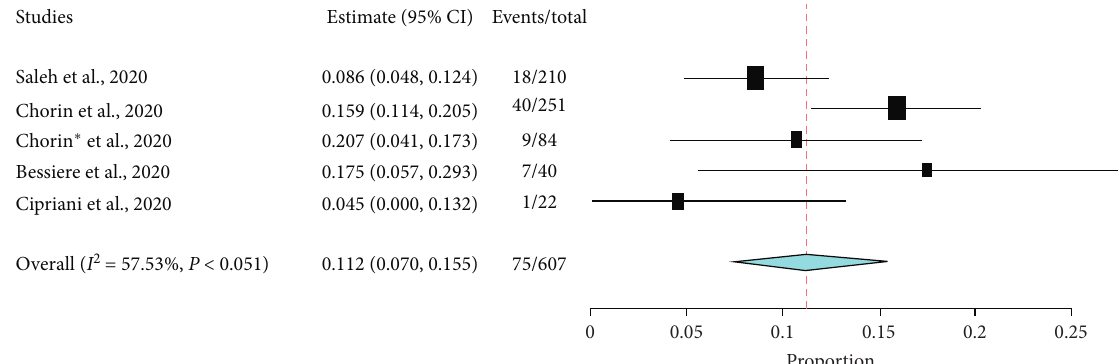
Figure 9: The proportion of COVD-19 patients with absolute QTc increase by more than 500ms after treatment with HCQ with or without